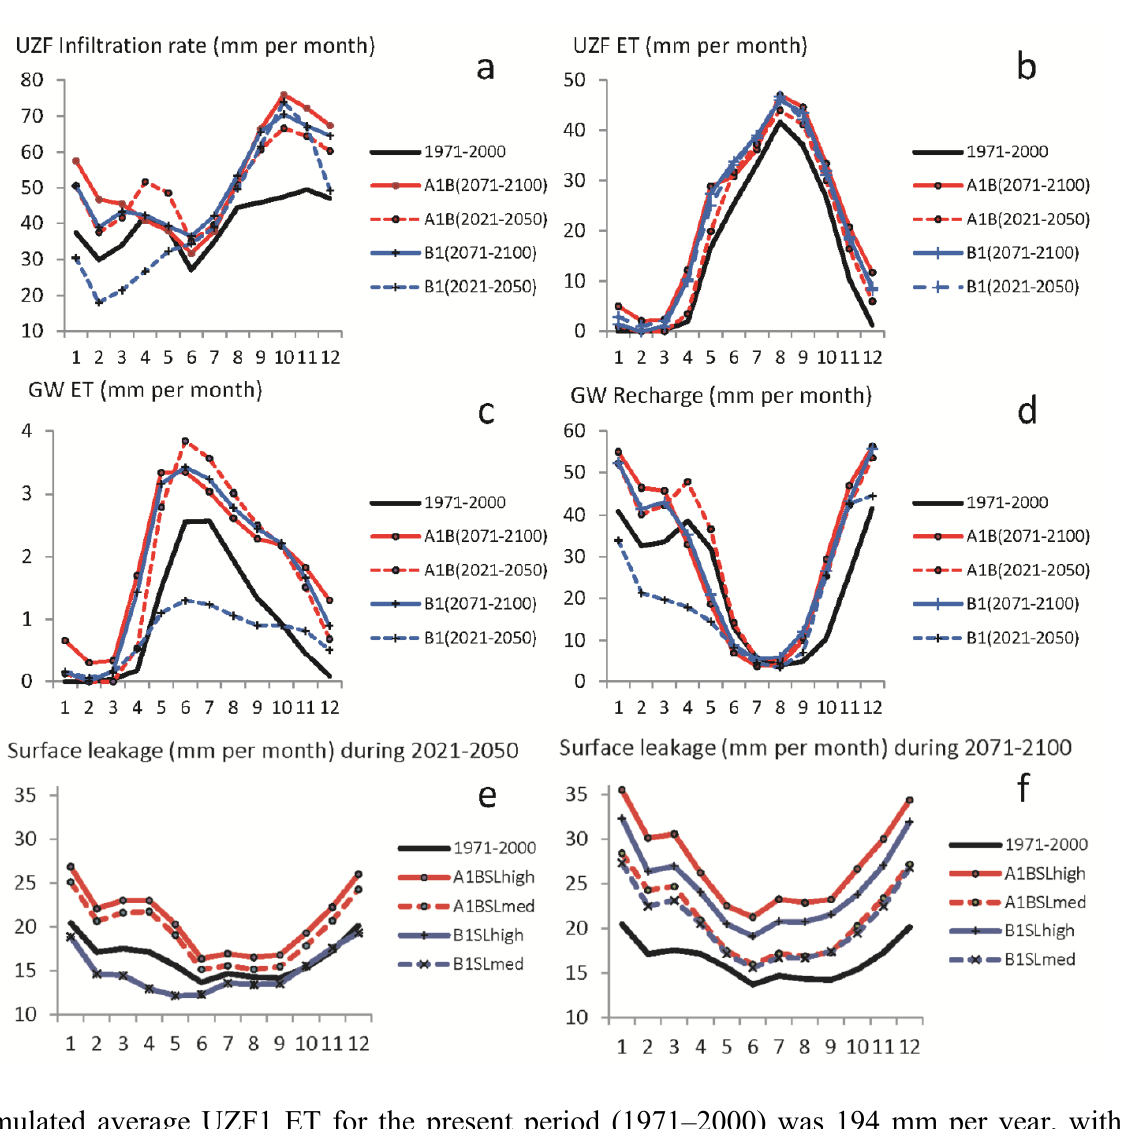
Figure 10. Mean monthly values (mm) of water balance variables in the A1B and